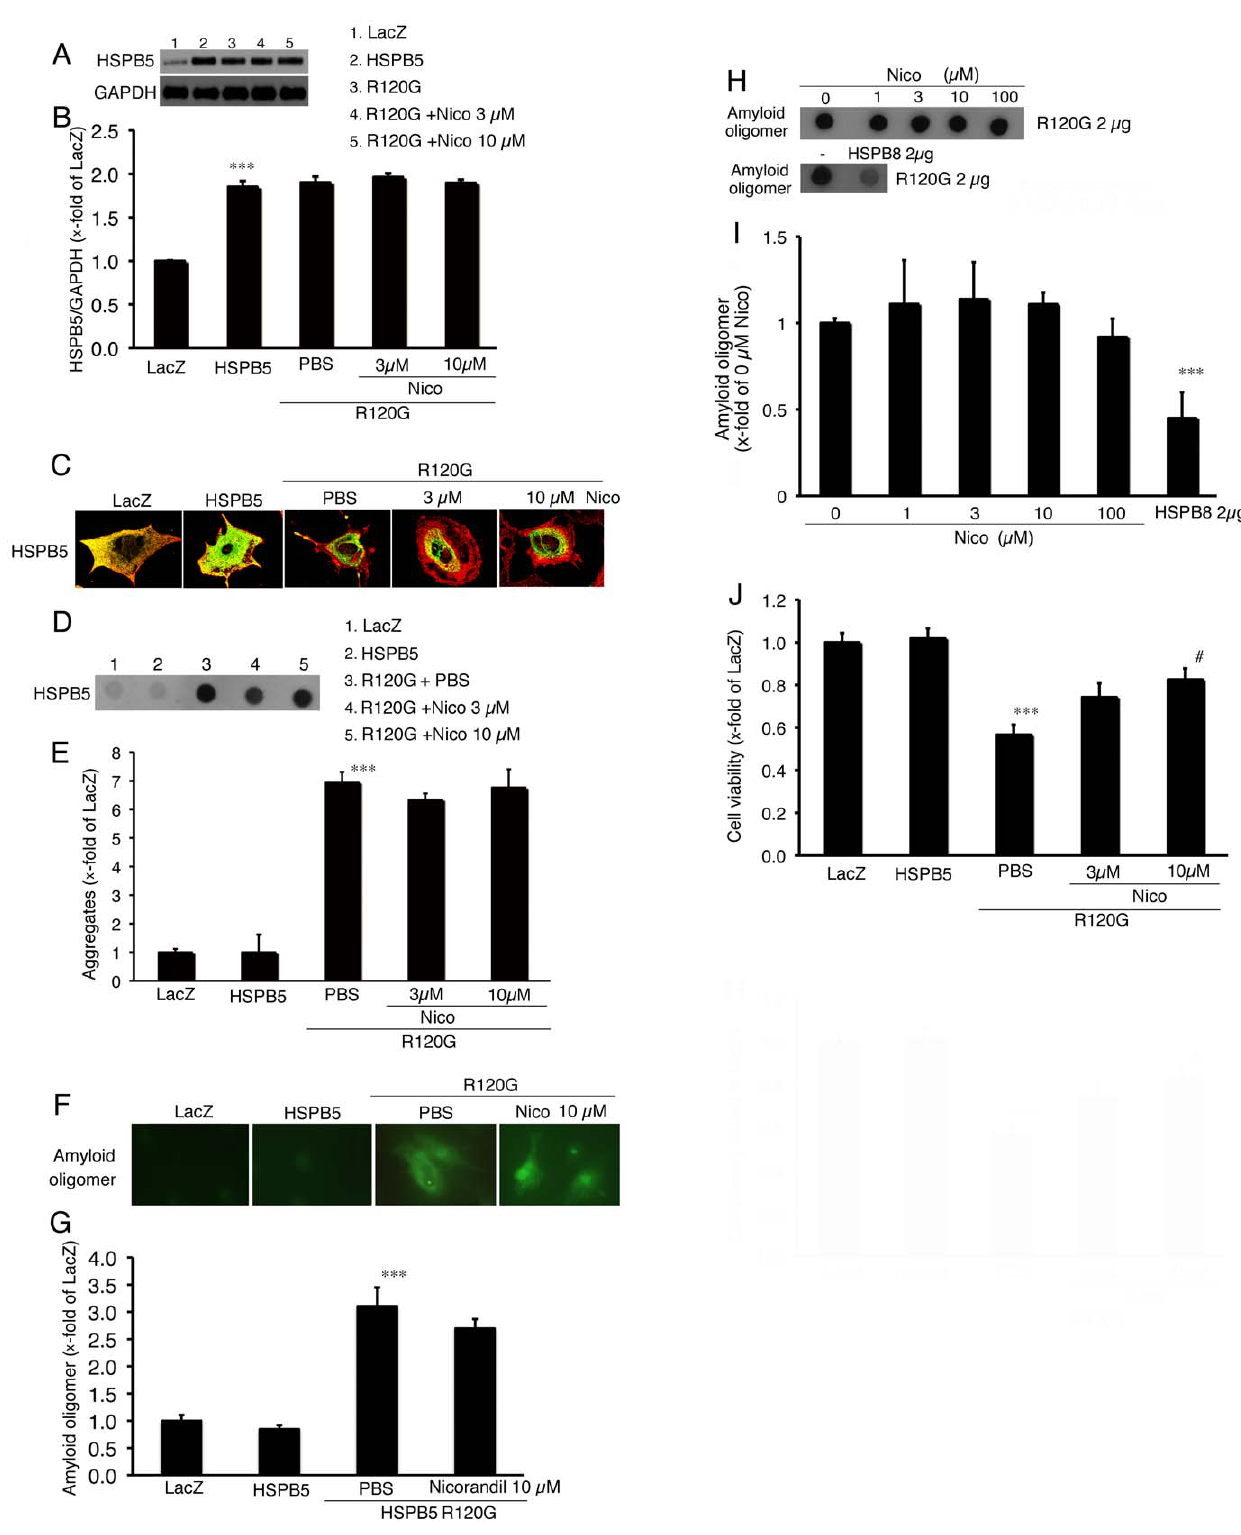
Figure 1. Effects of nicorandil (Nico) in neonatal rat cardiomyocytes expressing HSPB5 R120G (R120G). (A) Typical pictures of Western blot analysis. Cardiomyocytes were infected with the adenovirus vector containing the wild-type HSPB5 (HSPB5) or R120G with or without Nico treatment. (B) Quantitative analysis of HSPB5 (n=4). Values are the x-fold increase relative to cardiomyocyte cultures infected with the adenovirus vector containing LacZ whose values are arbitrarily set to 1. (C) Representative pictures of immunohistochemical analyses of the R120G-infected cardiomyocytes. HSPB5 (green) was detected by the anti-HSPB5 antibody as described in the Materials and methods section. To distinguish between the cardiomyocytes, cardiac troponin I was stained (red). (D) Typical picture of the filter assay for the detection of the aggregates. (E) Quantitative